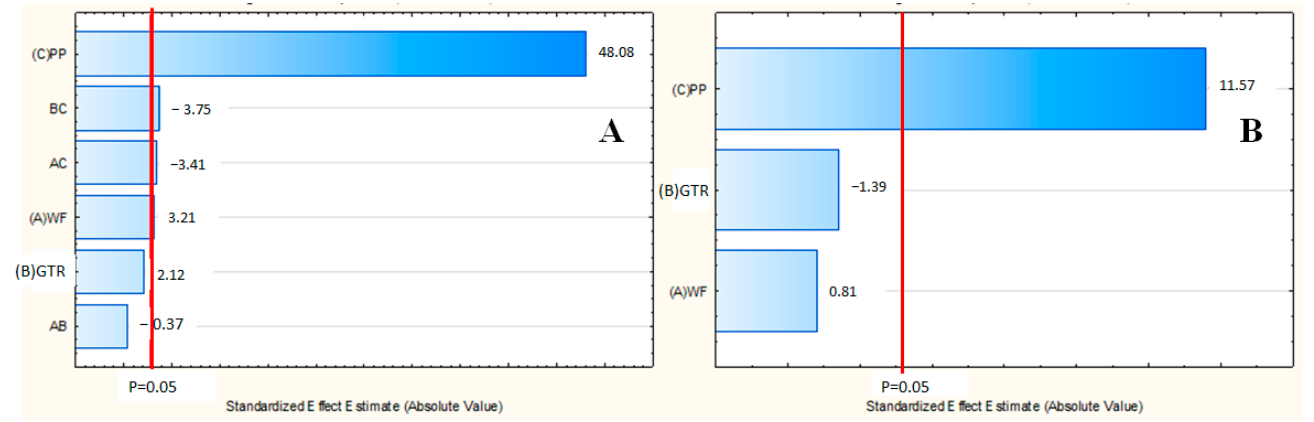
Figure 4. Tensile strength results of the untreated ( A ) and EB compatibilized ( B ) PP/GTR/WF composites showing the effect of interactions among the components.